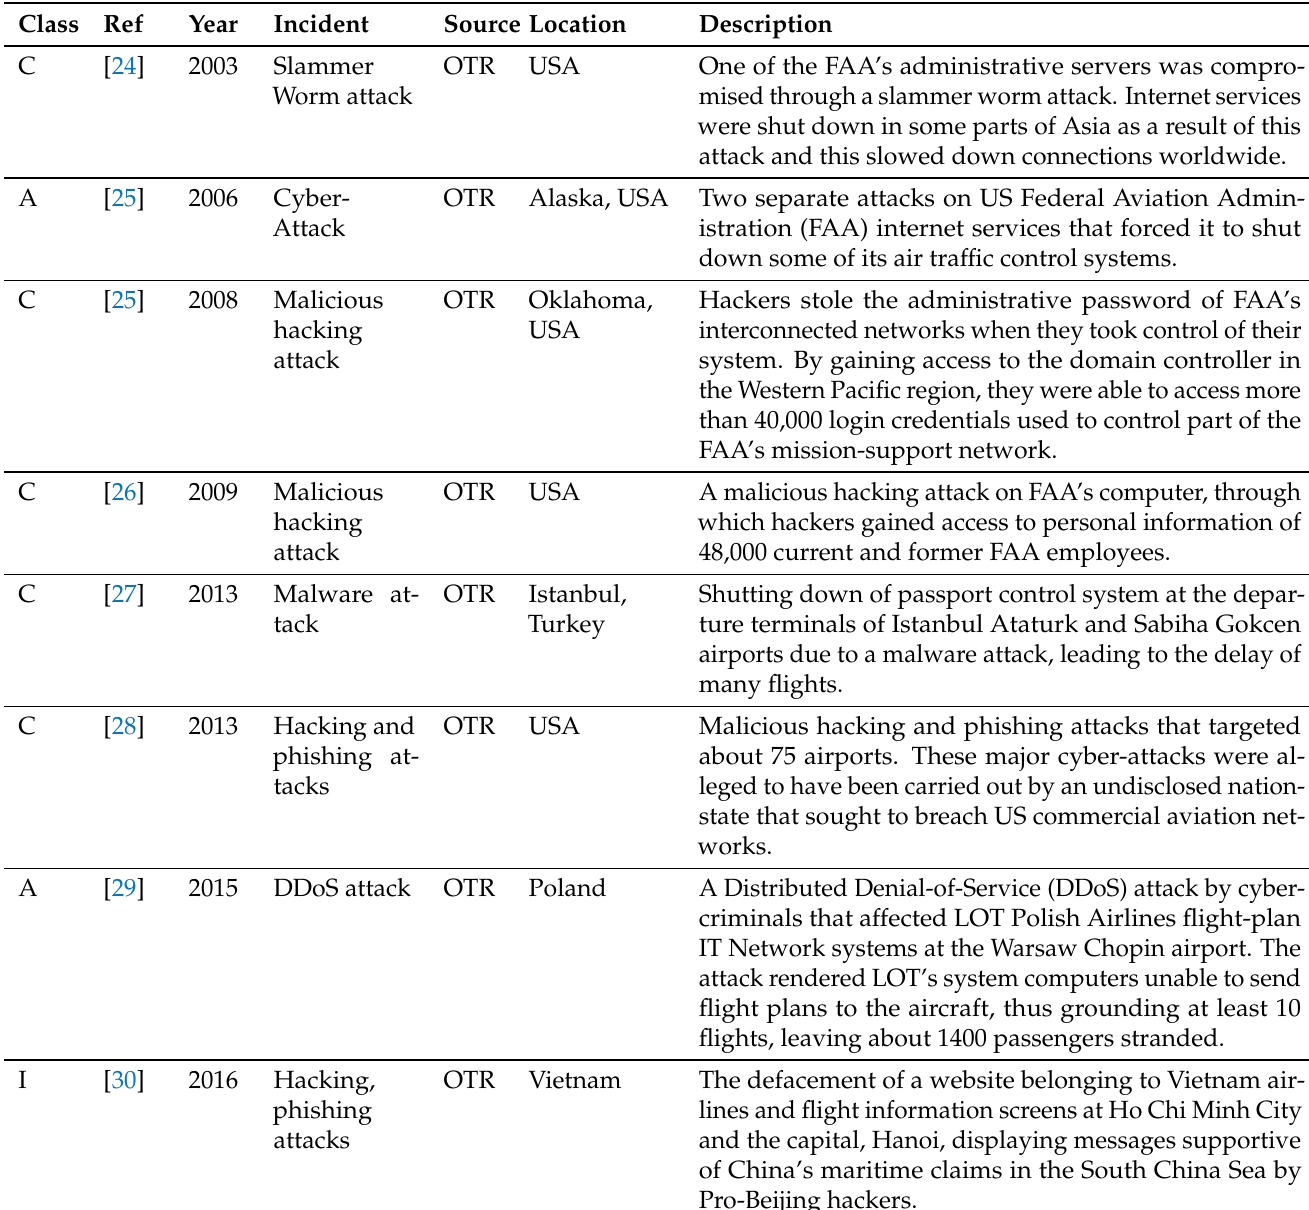
Table 2. Cyber-Attacks in the Civil Aviation